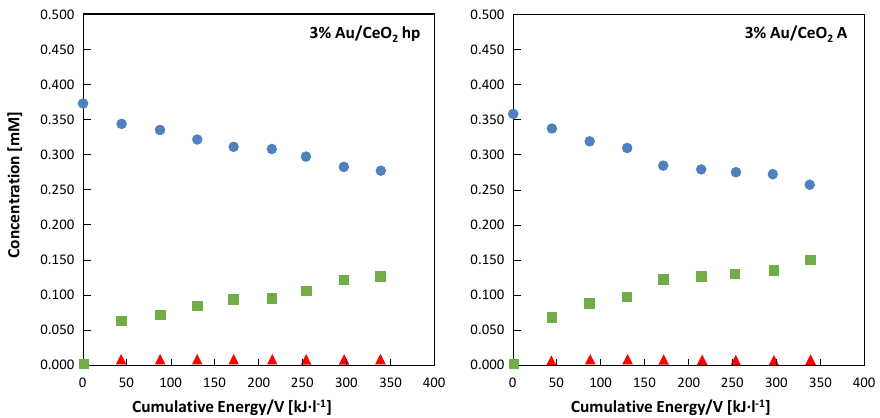
Figure 10. Natural solar light assisted partial photocatalytic oxidation of 4-MBA in the presence of the 3% Au-loaded CeO 2 samples. Evolution of 4-MBA concentration ( ● ), 4-MBAL ( ■ ) and 4-MBAcid ( ▲ ) versus natural sunlight cumulative energy (in the wavelength range 315–560 nm) entering the reactor per unit of volume of suspension. Figures 8 and 10 are representative of the same runs, consequently after 4 h of irradi- ation (240 min) the cumulative energy entering the reactor per unit of volume of suspen-